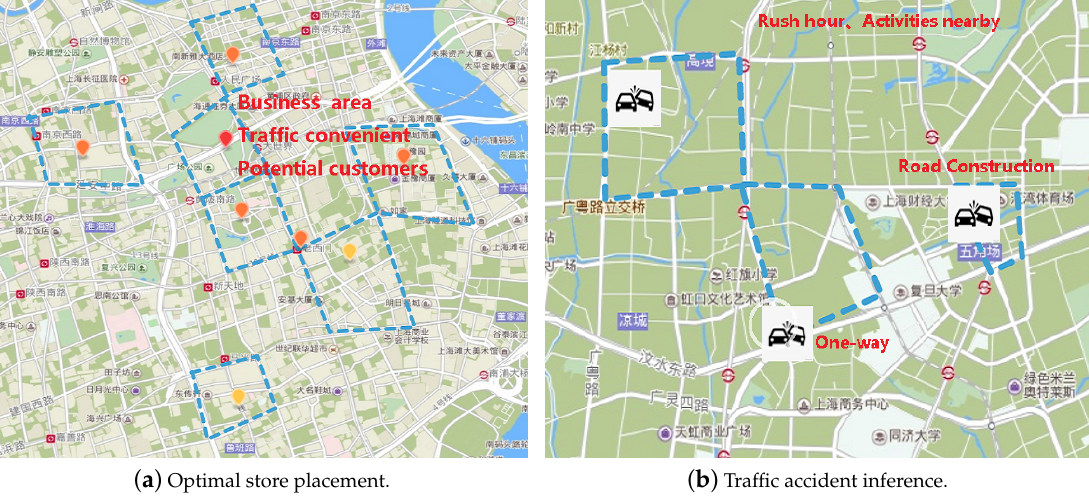
Figure 3. Visualization of predictions for smart